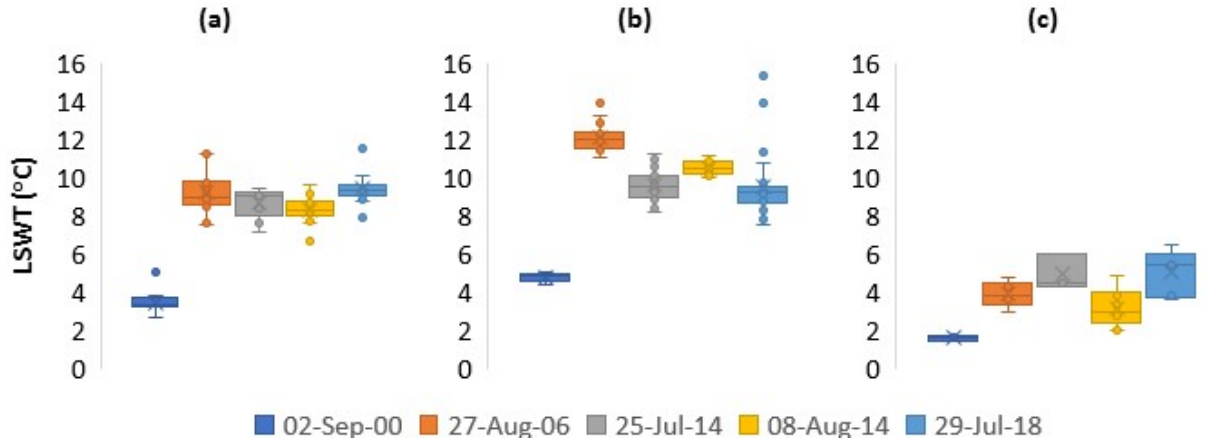
Figure 7. Box and whisker plots of lake surface water temperatures extracted from AST08 temperature product pixels for: ( a ) lake 3, ( b ) lake 4 and ( c ) lake 12 in Arctic Sweden on 2 September 2000 (dark blue), 27 August 2006 (orange), 25 July 2014 (yellow), 8 August 2014 (grey) and 29 July 2018 (light blue). Whiskers extend to points within 1.5 times the interquartile range (IQR) from the upper and lower quartile. Points 1.5 times the IQR from the upper and lower quartile are plotted as outliers. With x = mean and central line = median.